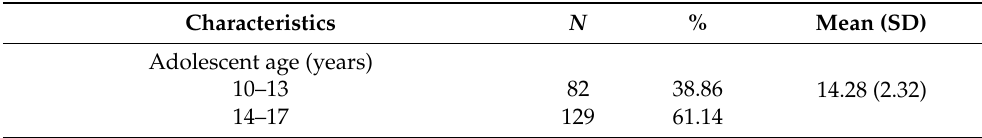
Table 1. Demographic characteristics for the African American dyad